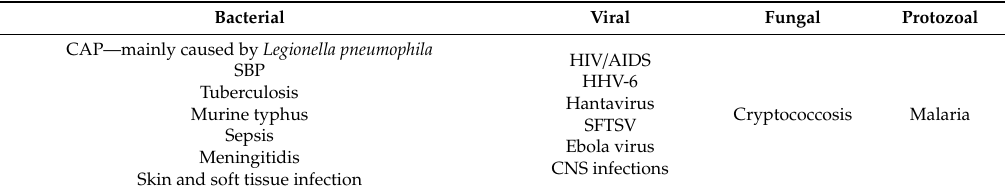
Table 1. Summary of the most common infectious diseases occurring with hyponatremia. Bacterial Viral Fungal